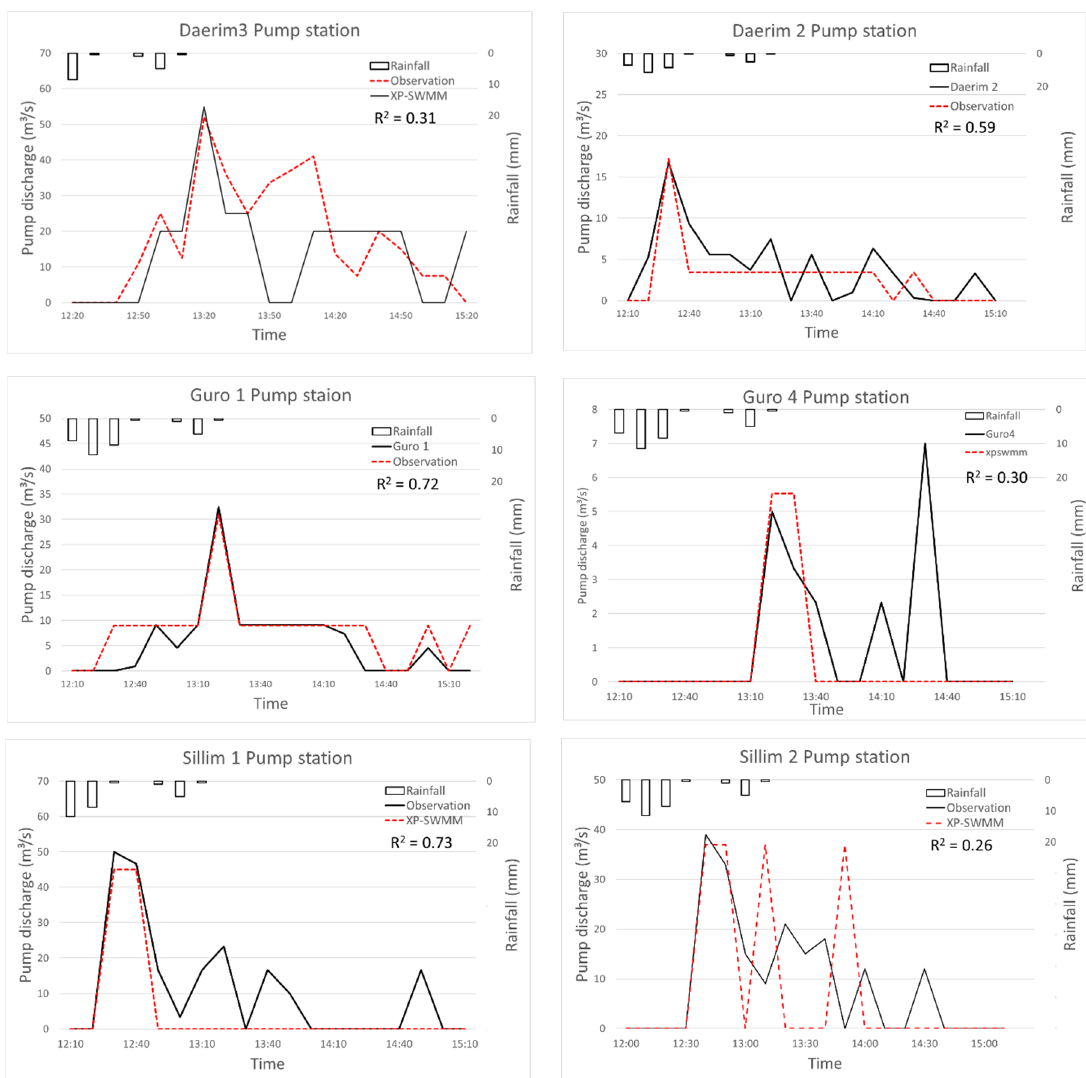
Figure 5. Rainfall-runoff model in Dorim basin by XP-SWMM.